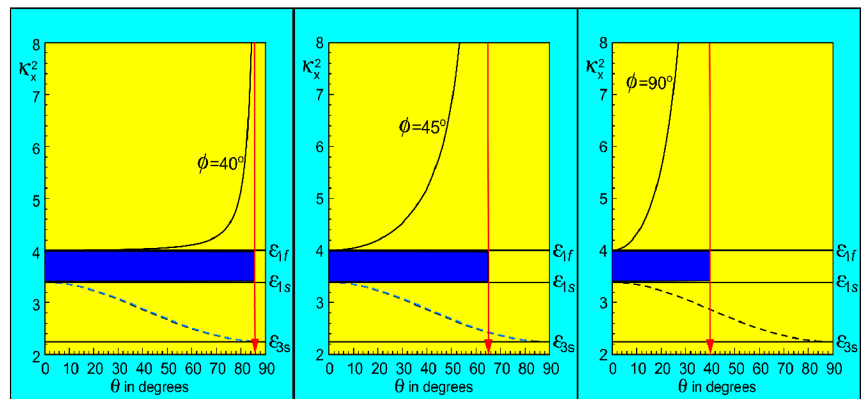
Figure 8. Above critical angle / c , the normalised wave number j z is no longer limited by the value of e 1 f , but, in the regions above e 1 f and below the solid curves, the modes are inhomogeneous. The blue areas are the regions where hybrid homogeneous modes occur. The figure shows the decreasing range of h over which these modes are possible as / increases beyond the value of / c . The dashed line is the result for the anisotropic substrate where as / changes the change in the graph is undetectable on the scale of the